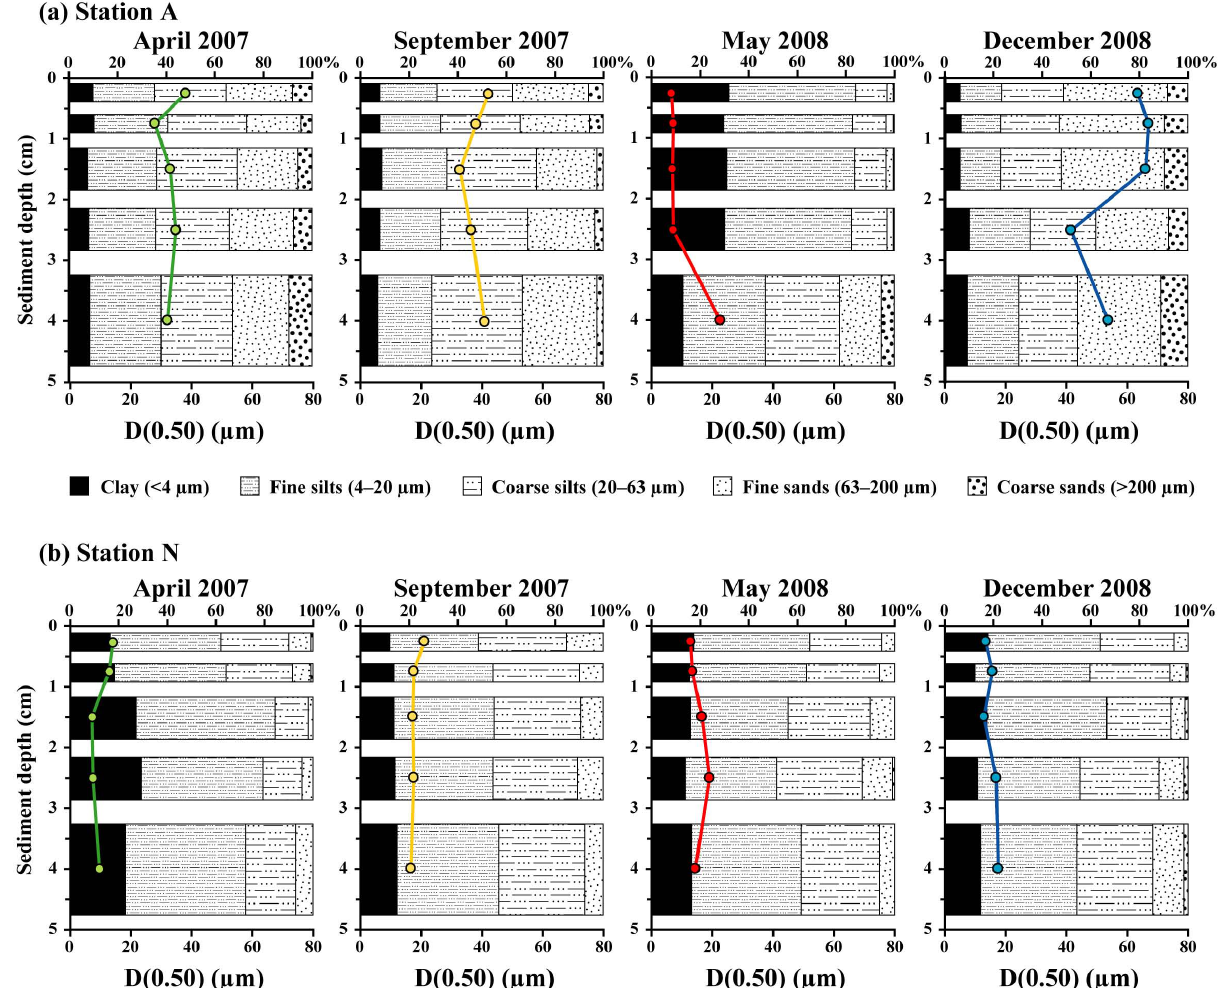
Fig. 3. Sediment composition along the top 5cm of the cores at both Stations A (a) and N (b). Horizontal bars represent clay, fine silts, coarse silts, fine sands and coarse sands contributions. Curves correspond to sediment median diameter D(0.50) for each sediment